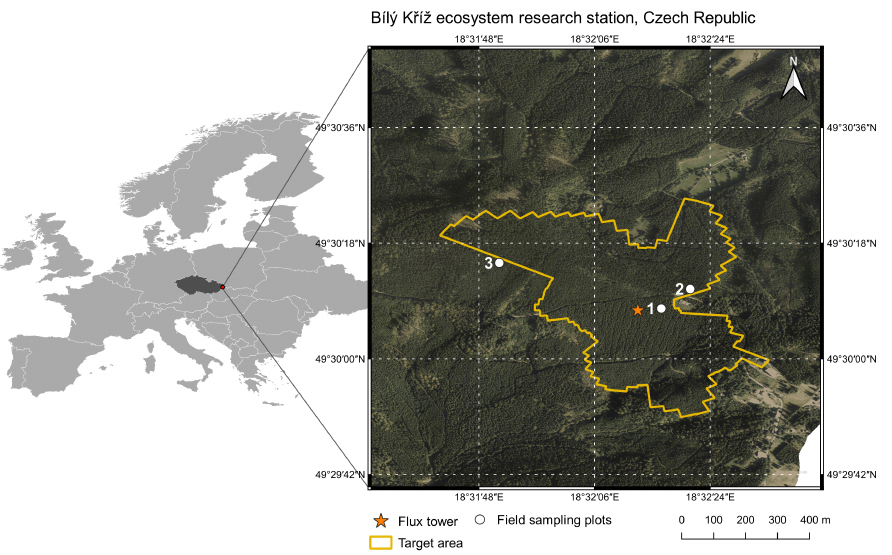
Figure 1. The locations of the eddy covariance flux tower, field sampling plots, and target area defined by the flux footprint at the Bílý Kˇríž research